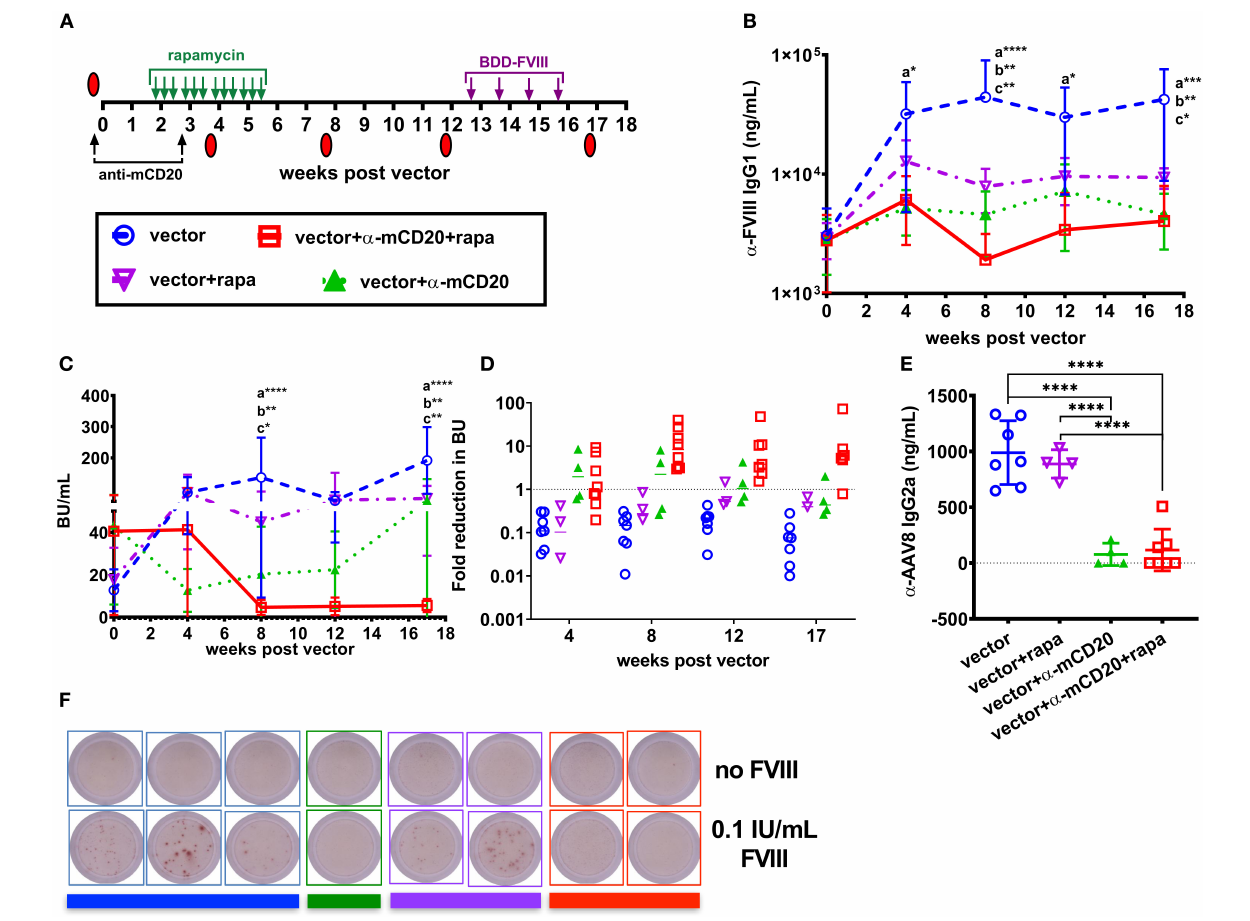
FIGURE 4 | AAV8- coF8 liver gene transfer enhances anti-mCD20 and rapamycin ITI. BALB/c-HA mice were IV challenged weekly for 4 weeks with 1.5 IU BDD-FVIII protein and bled at different time points to determine starting Bethesda inhibitor titers. Different groups were established that received vector only (1 × 10 11 vg AAV8-ApoE-hAAT- coF8 , n = 7 blue circle), vector and rapamycin ( n = 5 inverted purple triangle), vector and anti-mCD20 ( n = 5 green triangle), and vector with anti-mCD20 and rapamycin ( n = 8 red square). Vector and anti-mCD20 was administered at week 0 and a second anti-mCD20 at week 3, denoted with black arrows. Oral gavage with rapamycin was started 2 weeks after vector, three times per week for 4 weeks (green arrows). Summary of experimental timeline (A) . Mice were re-challenged with weekly IV injections of 1.5 IU FVIII starting at week 13 for 4 weeks. All mice received 1 × 10 11 vg of the AAV8- coF8 vector by tail vein injection. Plasma was used to measure anti-FVIII IgG1 levels (B) and Bethesda inhibitor titers (C) . The fold reduction in Bethesda inhibitor titers in relation to the starting titer for each mouse and group were calculated and reported in (D) . Values > 1 represent a reduction in Bethesda inhibitor titers, 1 no change, and < 1 an increase in Bethesda inhibitor titers. Plasma from 8 weeks post-vector was used to measure anti-AAV8 IgG2a antibody levels by ELISA (E) . Representative wells of a FVIII memory B cell ELISpot assay in which CD138 depleted splenocytes were cultured for 6 days in the absence or presence of 0.1 IU FVIII/mL (F) . Colored bars beneath the wells correspond to the donor group. Statistical analysis of (B,C) was conducted using two-way ANOVA with Tukey’s multiple comparisons test. Groups with significant differences are annotated a: vector vs. vector-anti-mCD20-rapamycin, b: vector vs. vector-anti-mCD20, and c: vector vs. vector-rapamycin with * p < 0.05, ** p < 0.01, *** p < 0.001, and **** p < 0.0001. Statistical analysis of (E) was conducted by one-way ANOVA with Tukey’s multiple comparisons